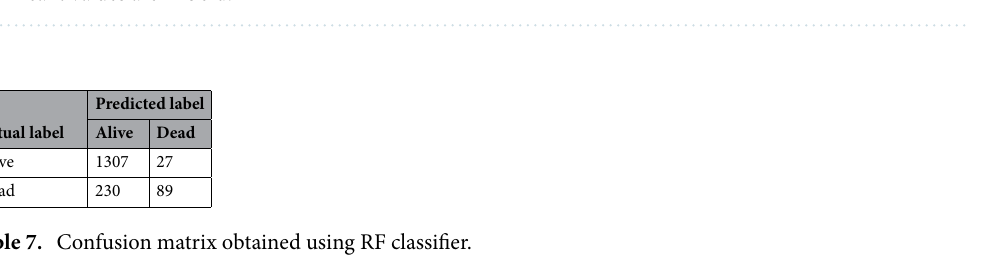
Table 6. The performance of different classification algorithms on 2-class-dataset according to gose0. Significant values are in bold.